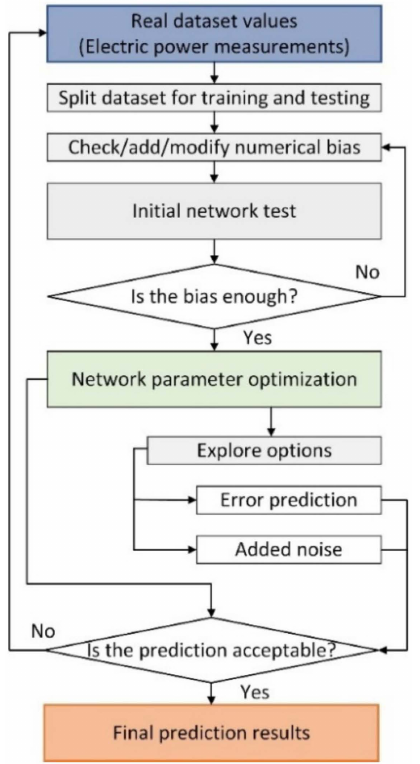
Figure 11. Unified electric power prediction